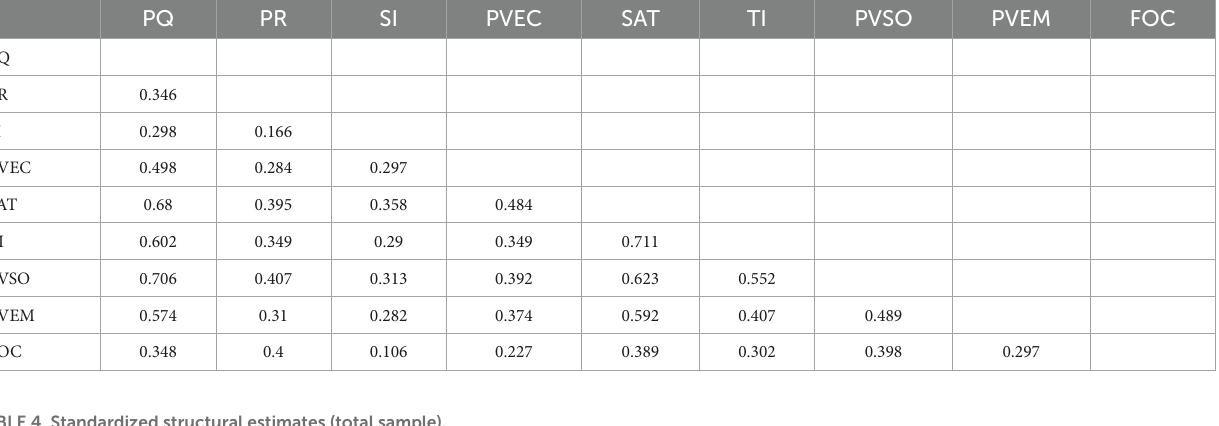
TABLE 4 Standardized structural estimates (total sample).